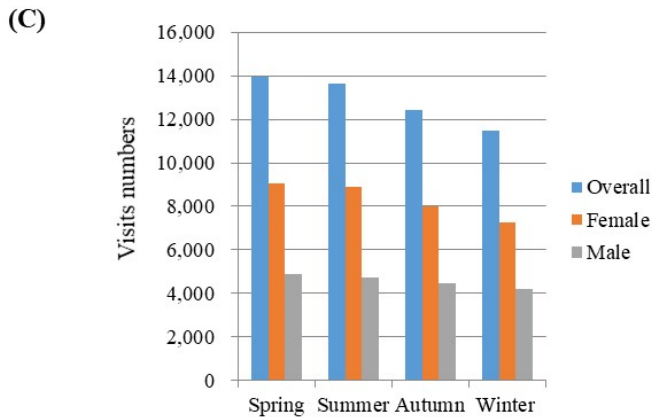
Figure 1. Time trends of the proportion of rosacea visits. ( A ) Number of total and first-time visits for rosacea between 2007 and 2018. ( B ) Temporal variation in the proportion of rosacea visits compared with all dermatological visits between 2007 and 2018. ( C ) The overall number of visits for rosacea in each season.